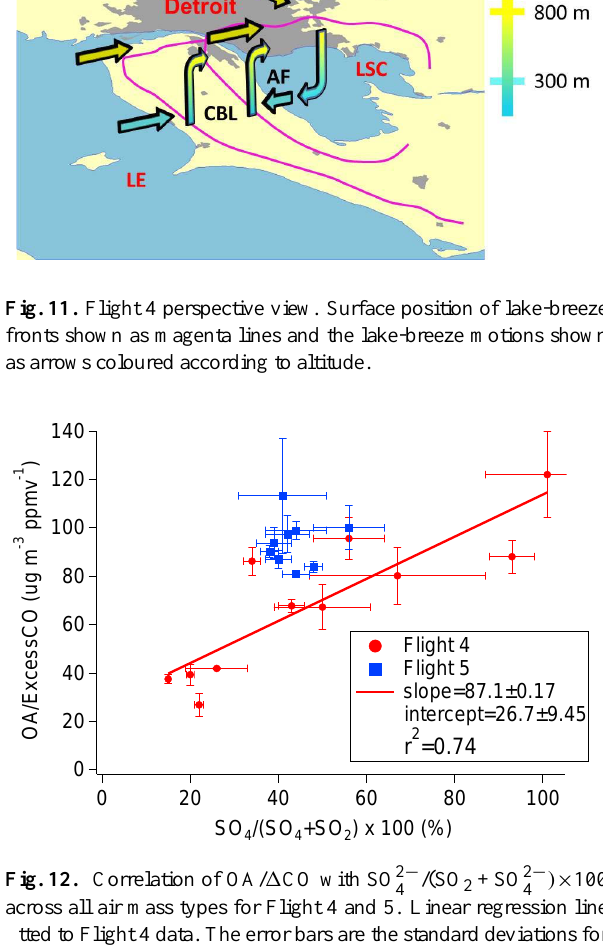
Fig. 12. Correlation of OA/ 1 CO with SO 2 − across all air mass types for Flight 4 and 5. Linear regression line fitted to Flight 4 data. The error bars are the standard deviations for each